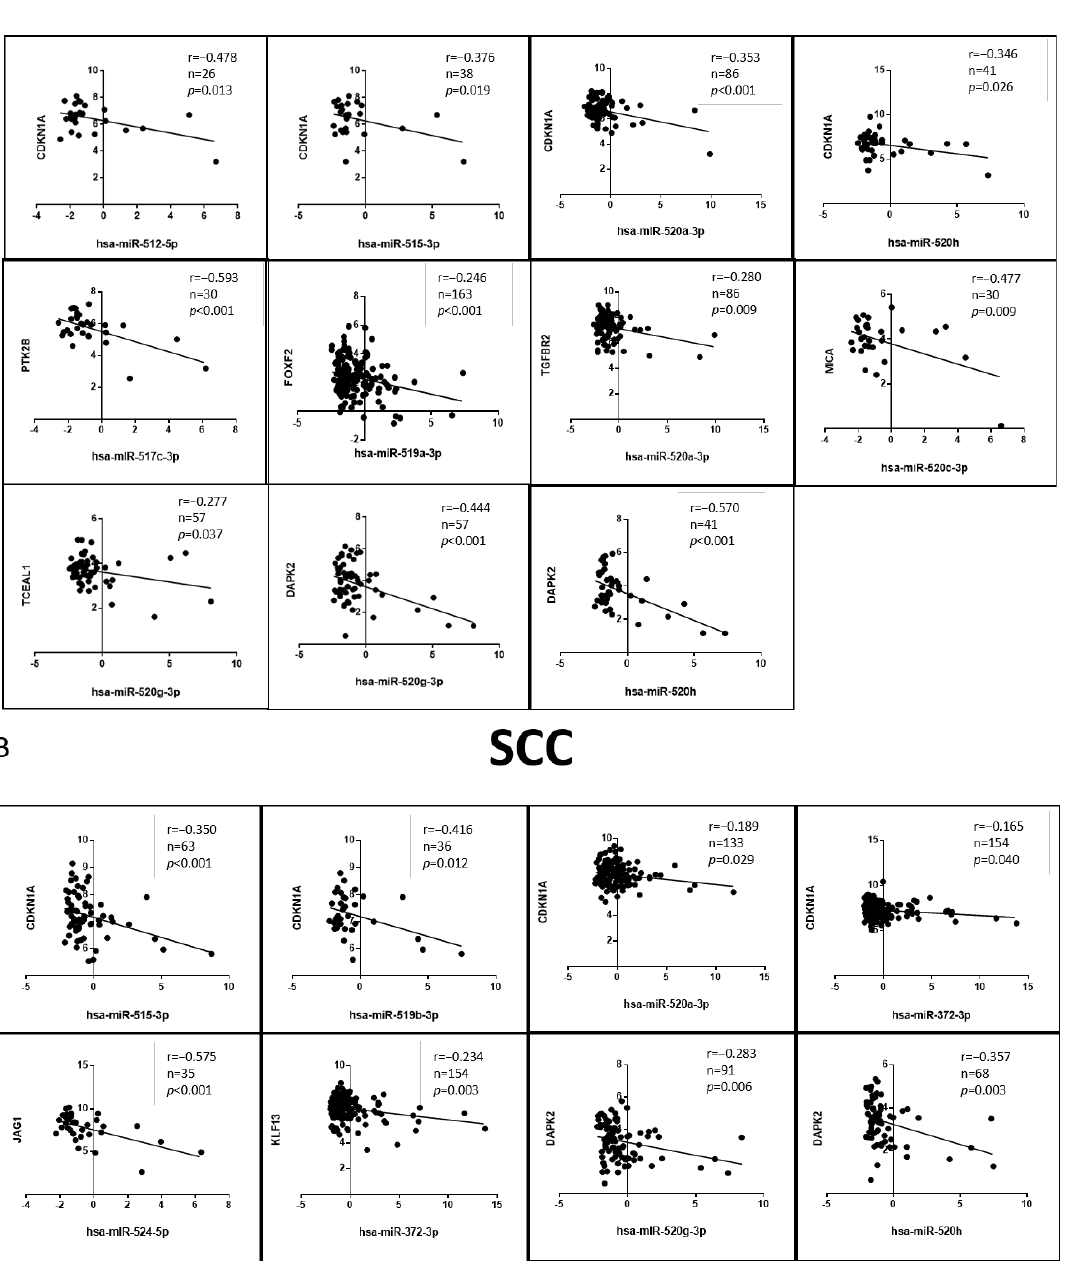
Figure 7. miRNA–target correlations in lung primary tumors. Significant negative correlations between miRNA–target for the C19MC and MIR371-3 miRNA clusters in ( A ) ADC and ( B ) SCC lung primary tumors. r: Pearson’s correlation coefficient; n: sample size, ADC: Lung Adenocarcinoma; SCC: Lung Squamous. p- values lower than 0.05 were considered statistically significant.